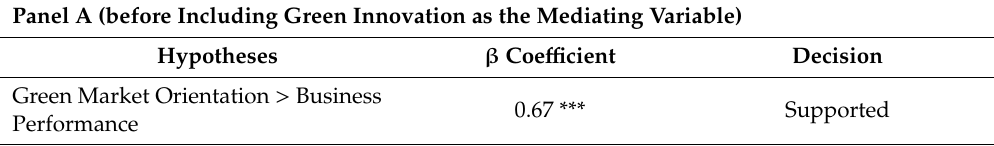
Table 5. Summary of the structural model